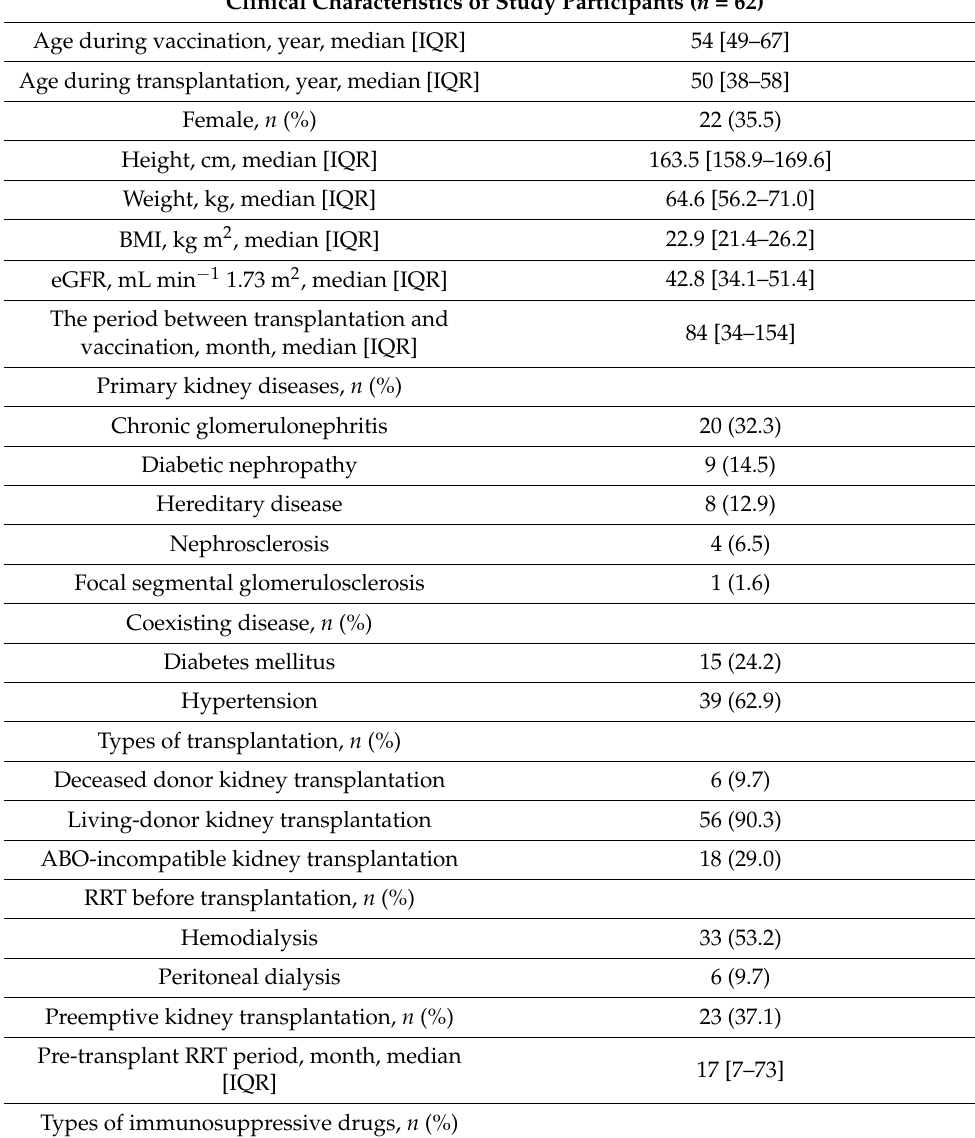
Table 1. Clinical characteristics of study participants ( n = 62). Clinical Characteristics of Study Participants ( n =